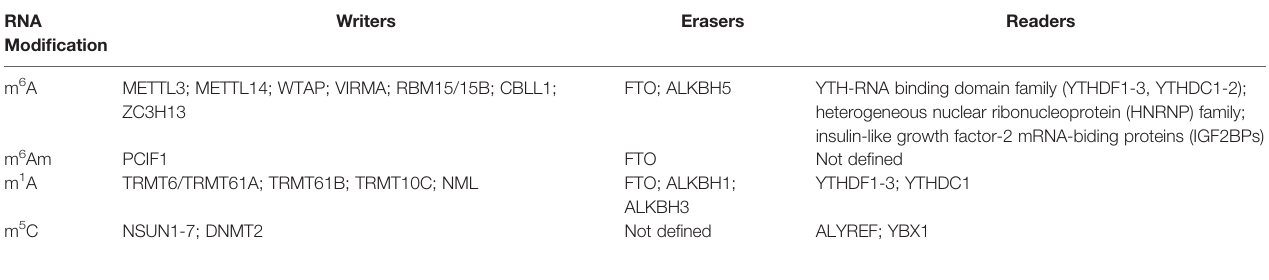
TABLE 1 | Writers, readers and erasers in predominant RNA